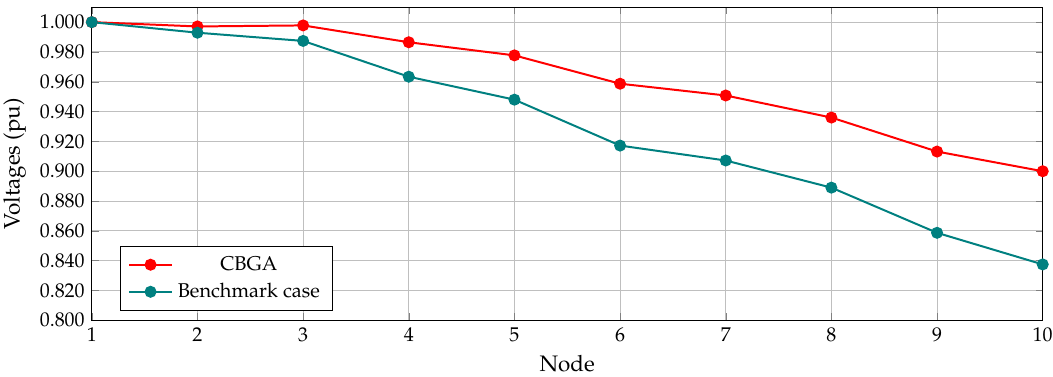
Figure 9. Voltage profiles in the 10-node system